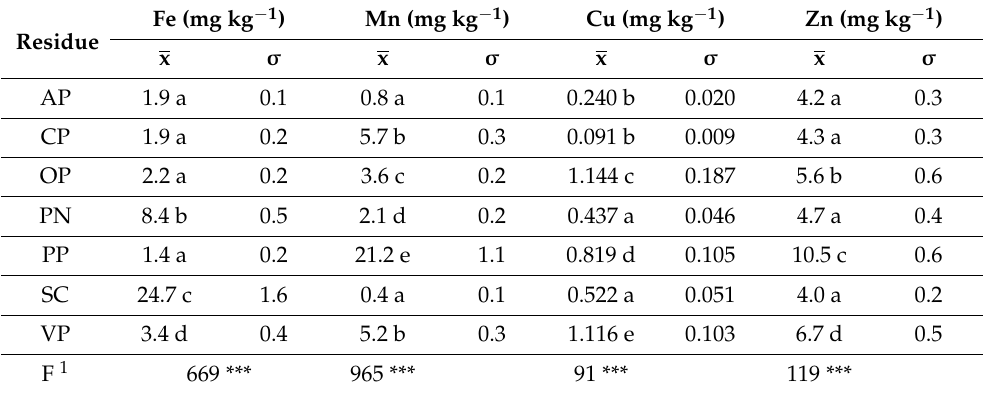
Table 6. Water extract micronutrients average content (x) and standard deviation ( σ ) of each residue.